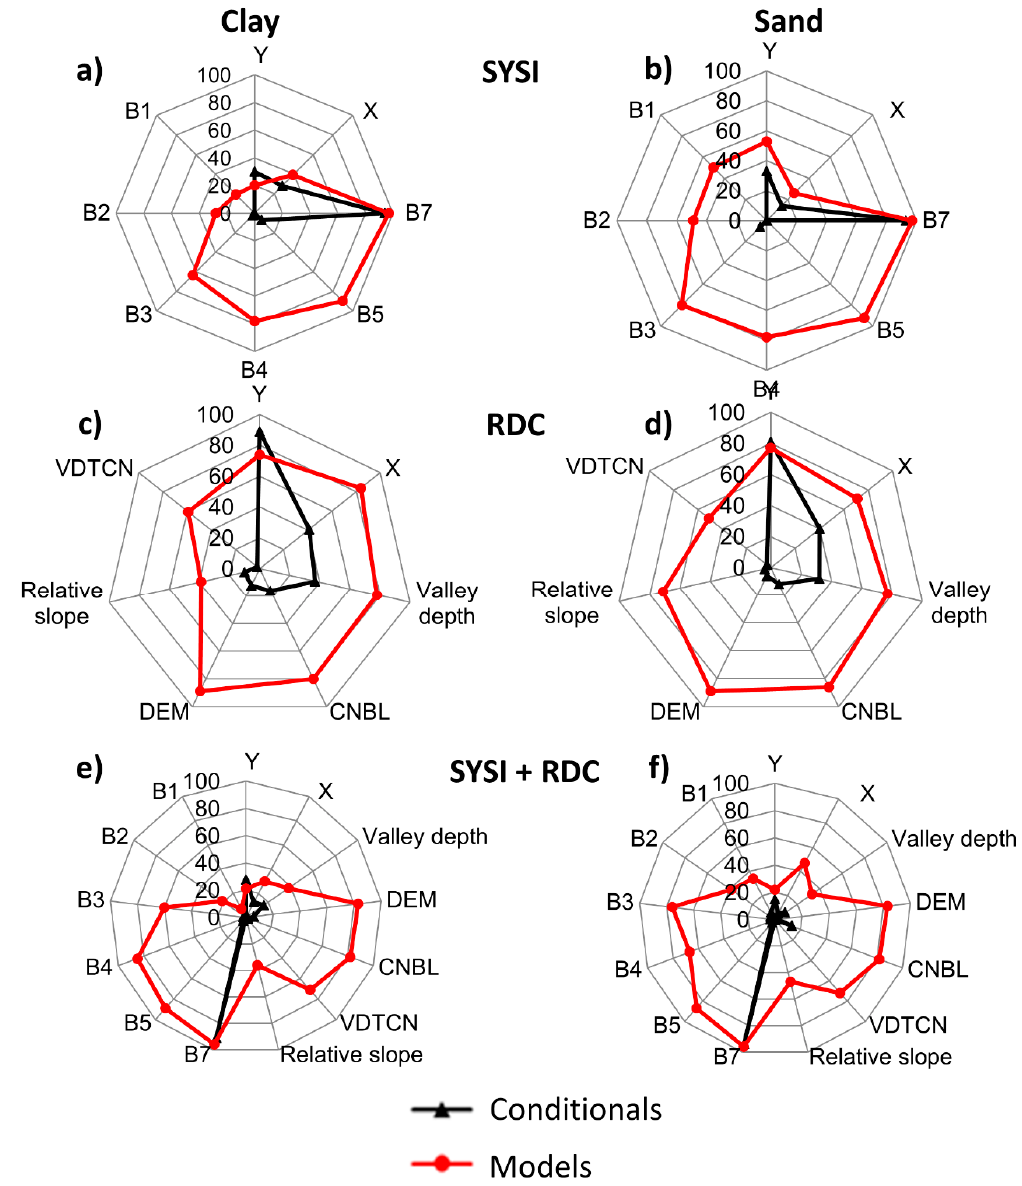
Figure 5. Variable contributions for clay and sand Cubist models using three approaches: only the Synthetic Soil Image (SYSI) ( a , b ), only the Relief-Derived Covariates (RDC) ( c , d ), and SYSI plus RDC ( e , f ). DEM: Elevation from Digital Elevation Model; CNBL: Distance from Channel Network to Base Level; VDTCN: Vertical Distance To Channel Network; X: Easting geographical Cartesian coordinate related to WGS84 UTM zone 23S; Y: Northing geographical Cartesian coordinate related to WGS 84 UTM zone 23S. Spectral reflectance from the Synthetic Soil Image (SYSI), equivalent to Landsat 5 Thematic Mapper spectral bands ranges (B1 to B7).